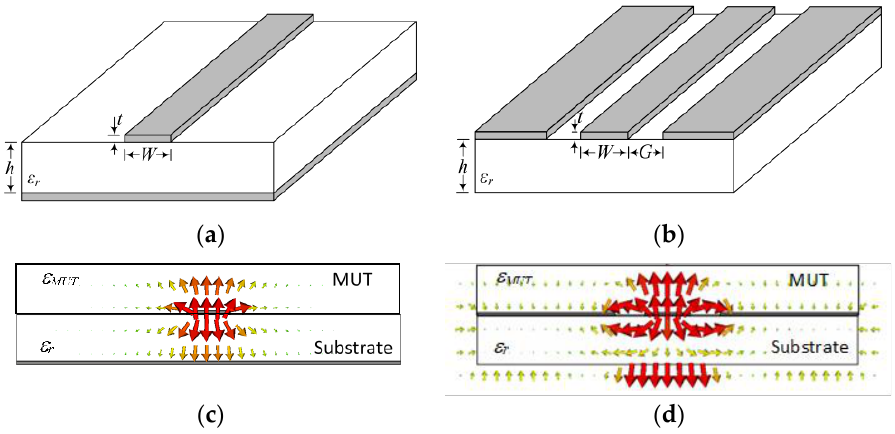
Figure 1. Perspective view of a microstrip line ( a ) and CPW ( b ) surrounded by air, and cross-sectional view of the microstrip line ( c ) and CPW ( d ) covered by a MUT. The electric field lines are indicated.